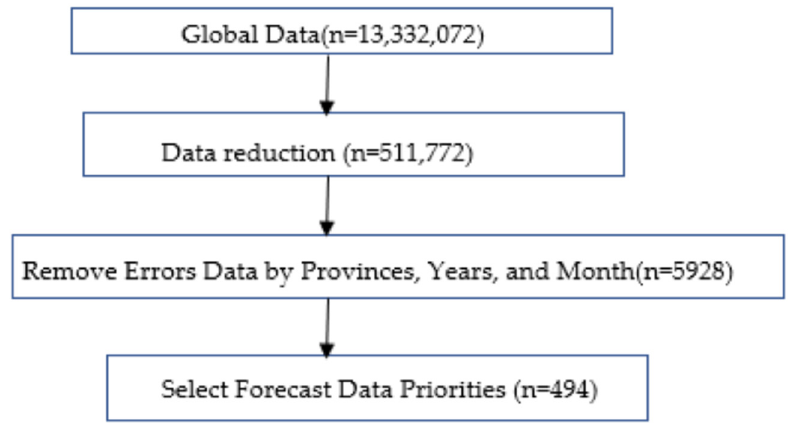
Figure 3. Sample flow chart for the analysis.